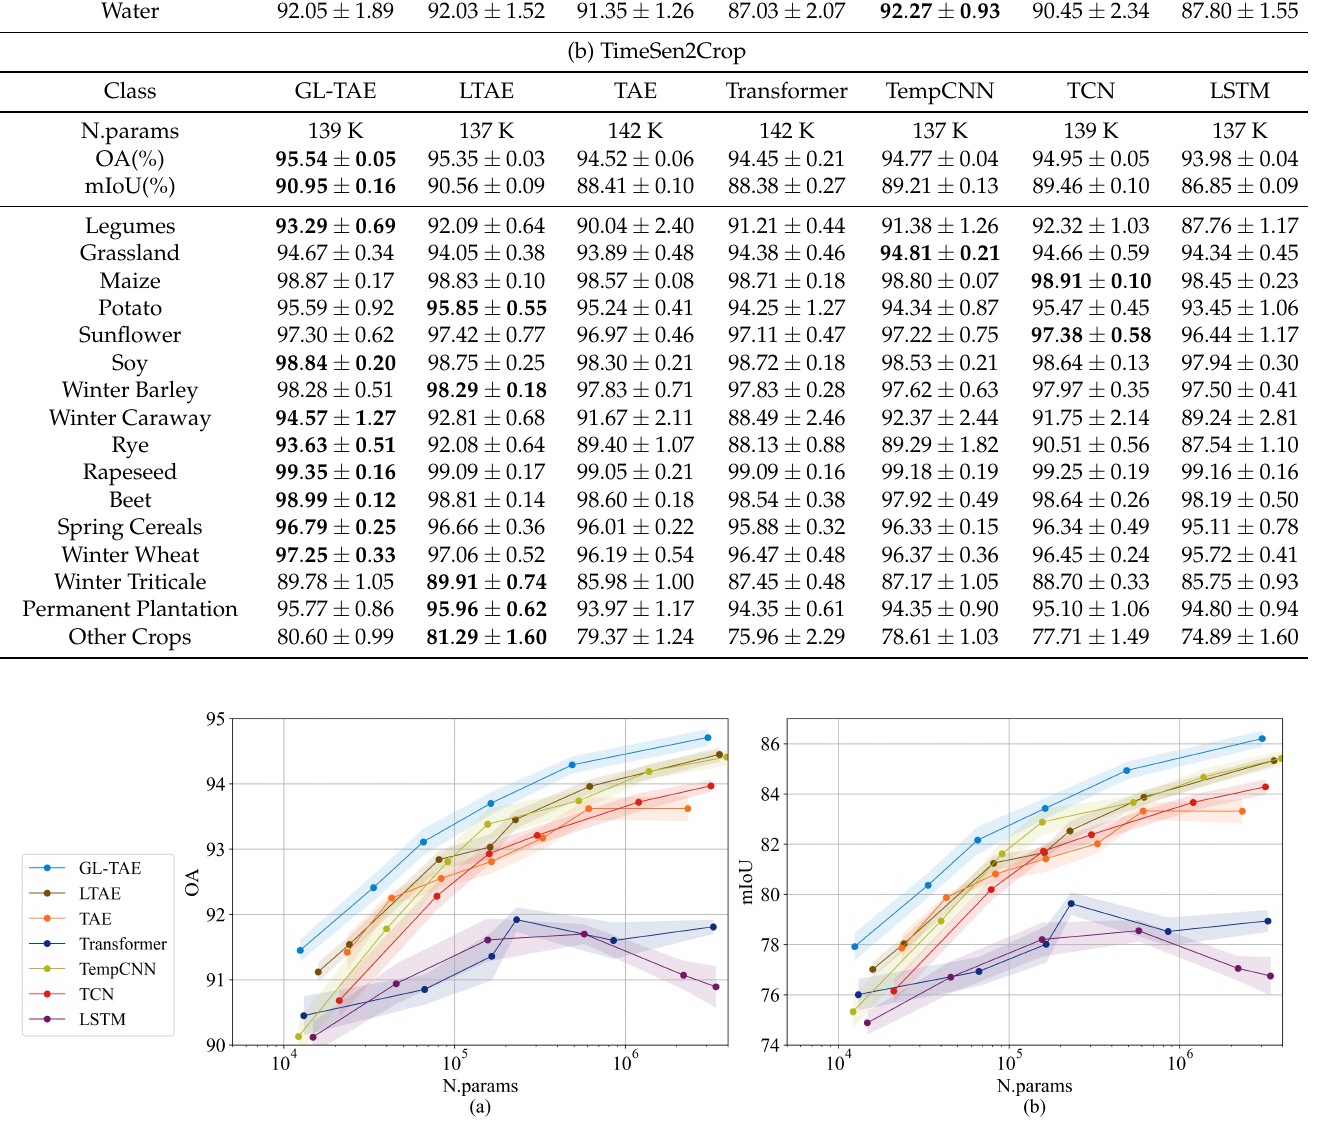
Figure 4. Performance in ( a ) OA and ( b ) mIoU on TiSeLaC of different methods plotted with respect to the parameter numbers. The axis of parameters is given on a logarithmic scale and the light shaded areas represent the standard deviations of OA/mIoU across the five cross-validation